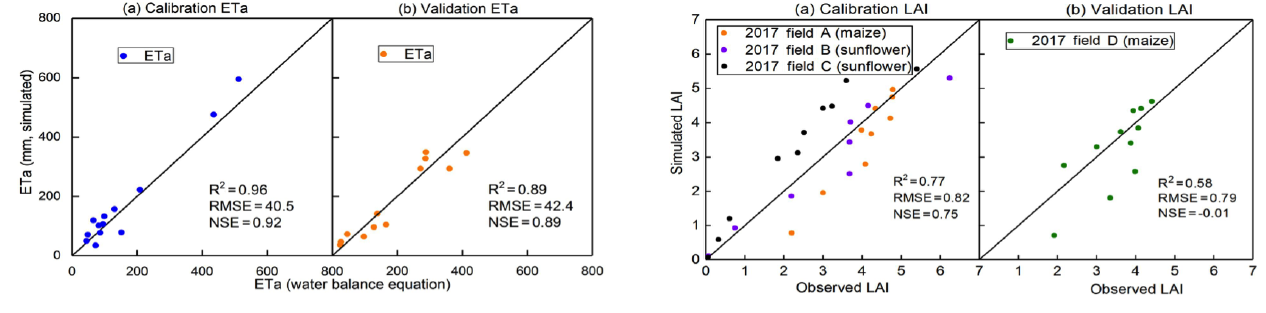
Figure 11. Comparison of predicted and observed actual evapotran- spiration: (a) calibration and (b) validation.